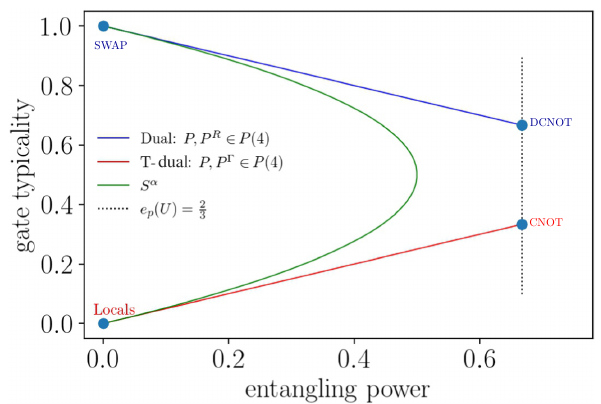
FIG. 9. The two-qubit case d 2 = 4. The entangling power versus the gate typicality of all permutations P ( 4 ) , treated as two-qubit gates. The number of entangling classes, those with different entangling powers, is 2.